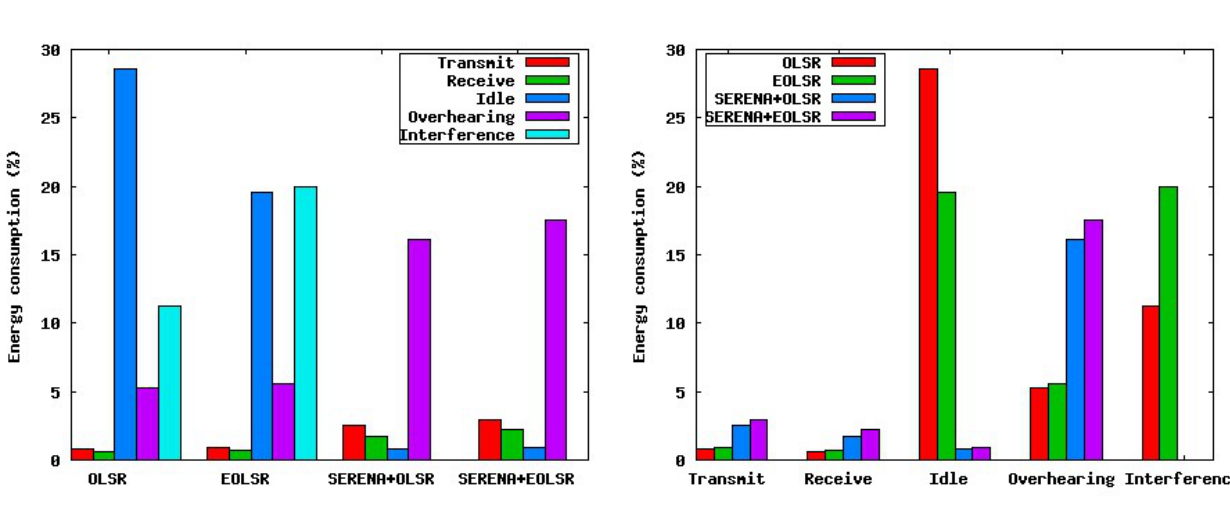
Comparison of the energy consumption in OLSR, EOLSR, OLSR+SERENA,